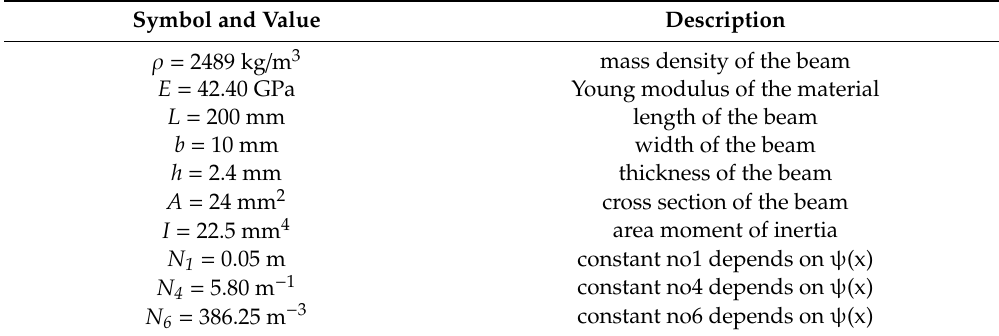
Table 1. The parameters of the composite material beam.